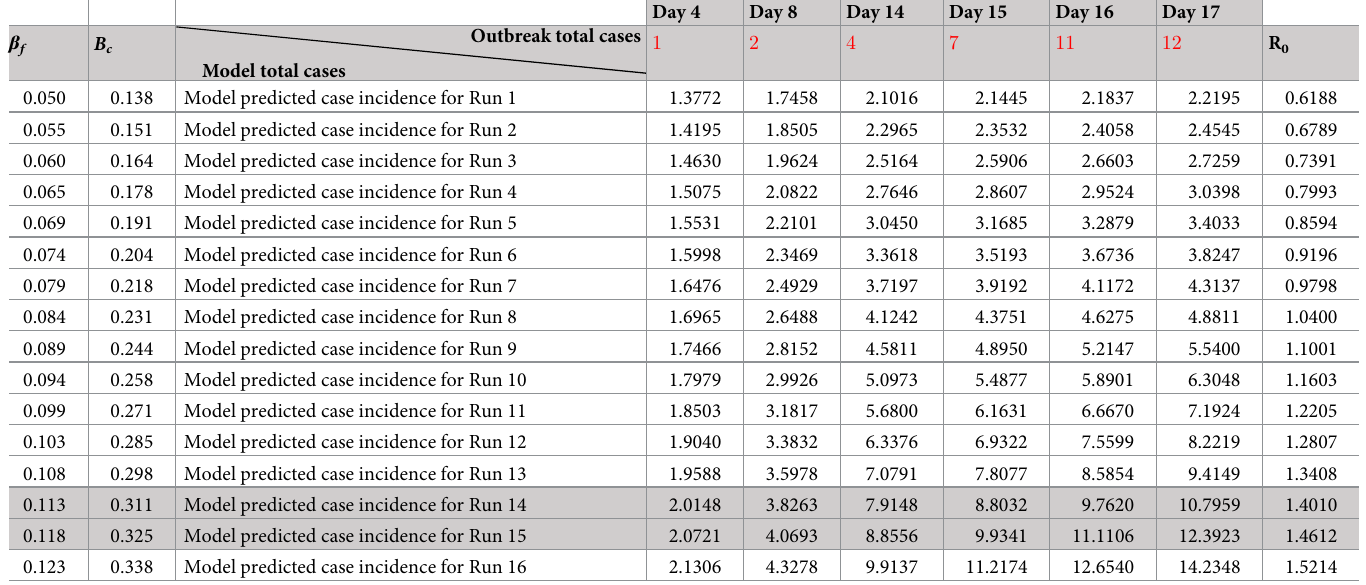
Table 5. The model predicted cumulative cases on day 4, 8, 14, 15, 16, and 17 for the 2015 Nyimba bubonic plague outbreak based on the different values of β f and